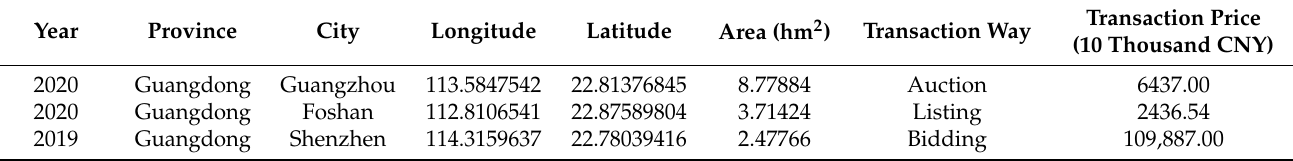
Table A3. The example of land transaction data from the Landchina